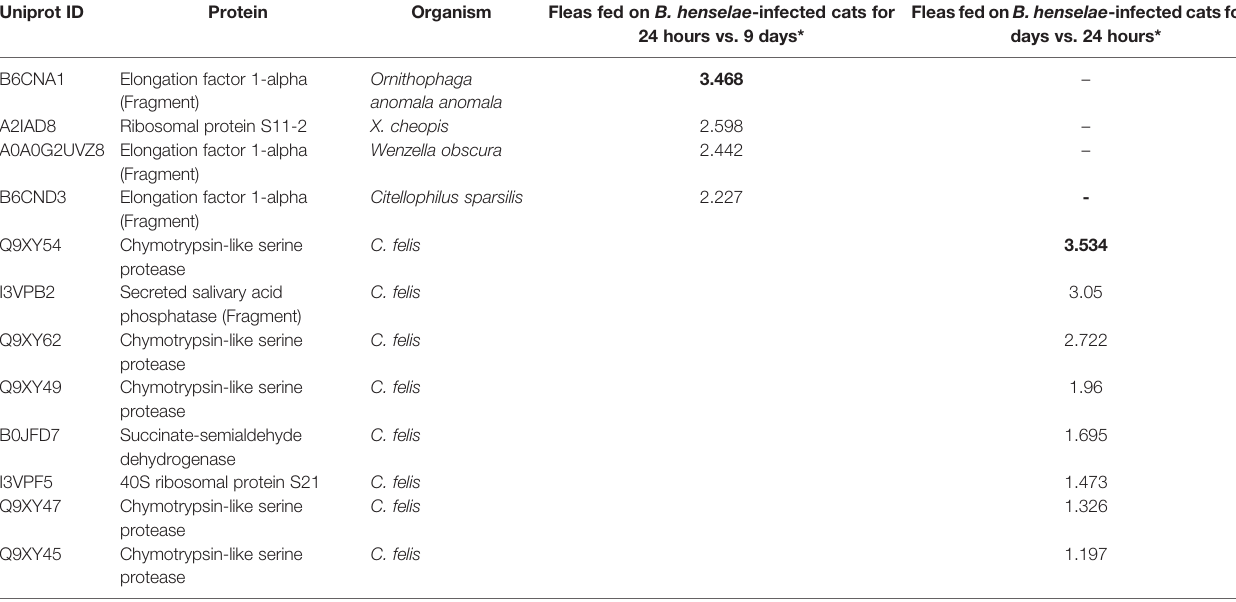
TABLE 7 | Uniprot identi fi cation number, associated protein, and reference organism of FDAP (Flea Differentially Abundant Proteins) in fl eas fed on B. henselae -infected cats for 24 hours when compared to those fed for 9 days, and fl eas fed on B. henselae -infected cats for 9 days when compared to those fed for 24 hours. Uniprot